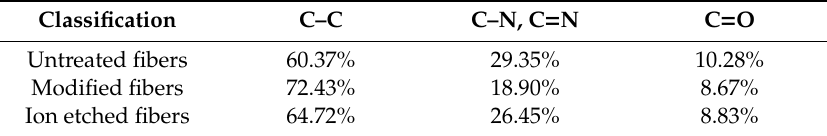
Table 2. C1s analysis of untreated aramid fibers and sample 2 in Table 1.